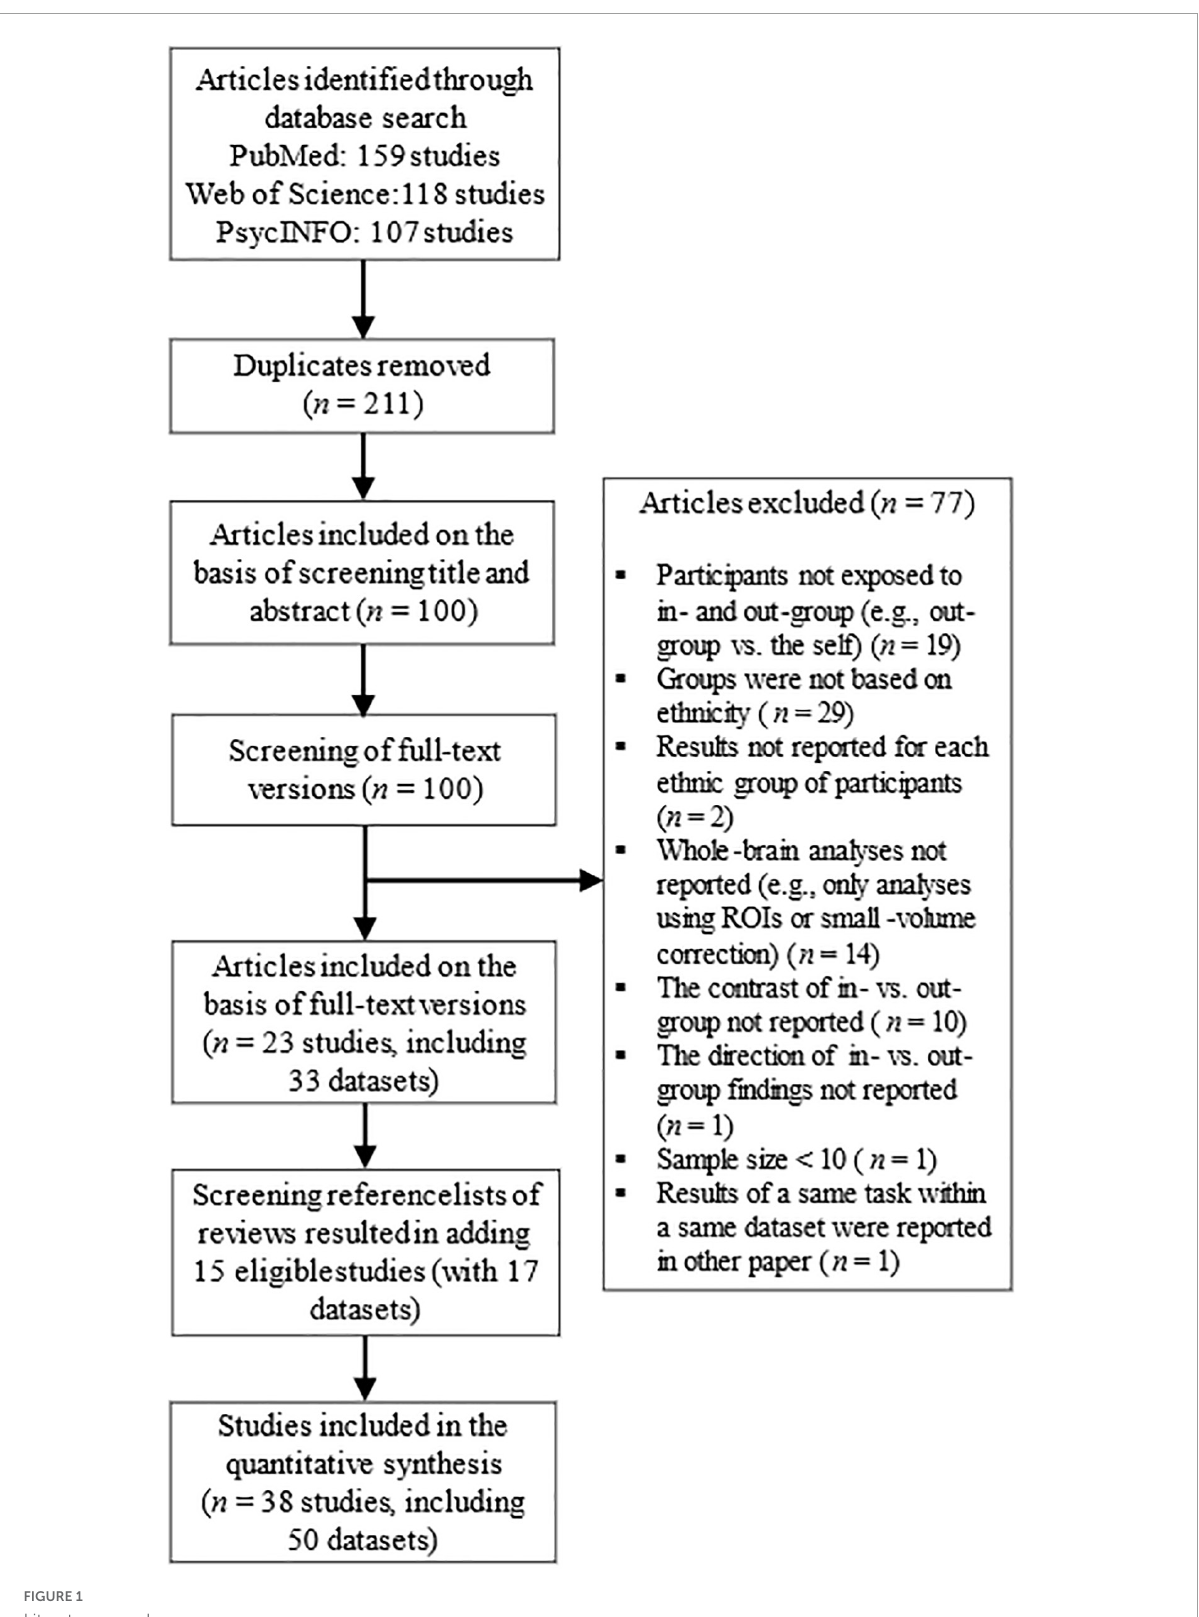
FIGURE1 Literature search